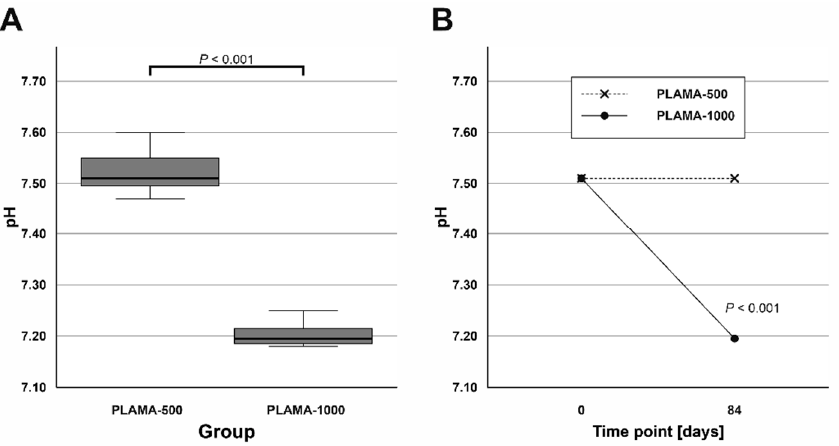
Figure 11. Comparison of the measured pH value in SBF in PLAMA-500 and PLAMA-1000 after the immersion test ( A ); changes in the pH level of the fluid in both groups after the test ( B ).